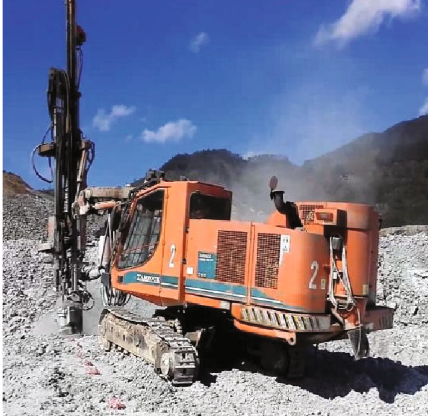
Figure 3: Down-the-hole drilling.